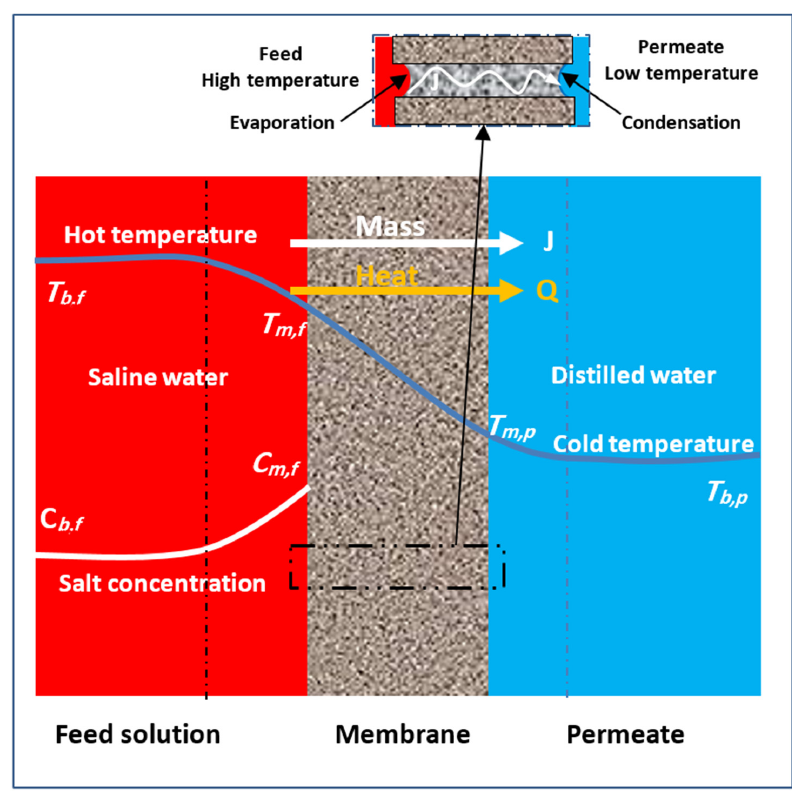
Figure 1. Schematic diagram of the transport mechanism of the direct contact membrane distillation (DCMD) process.